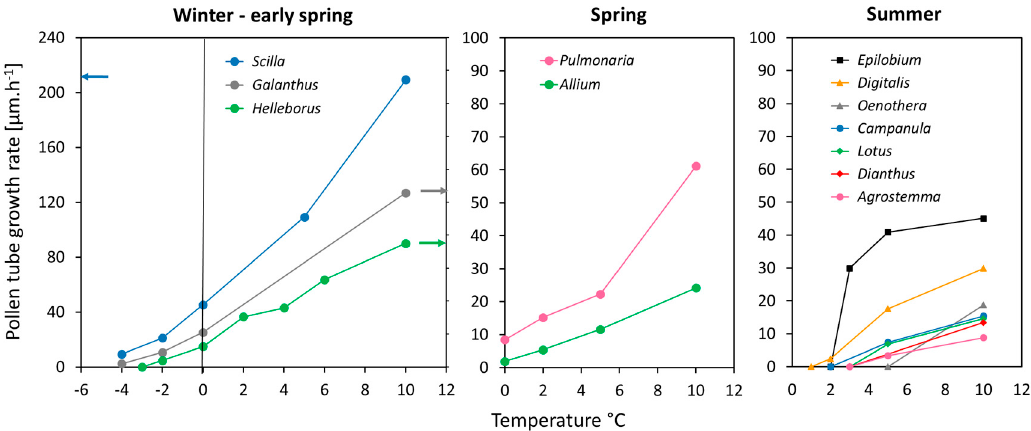
Figure 5. Mean pollen tube growth rates of the different phenotypes in dependence of temperature. Arrows in the diagram for winter and early spring species mark the affiliation of the data set to the left ( Scilla ) and right ( Galanthus , Helleborus ) y -axis.